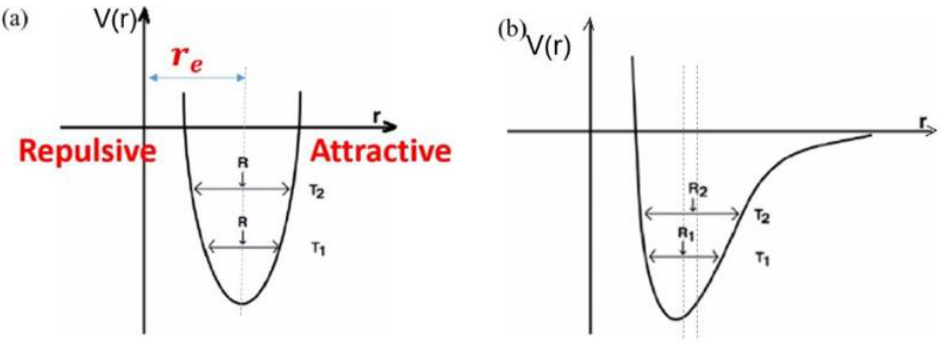
Figure 3. Relationship between the potential energy of ( a ) harmonic and ( b ) nonharmonic motion and atomic distance.